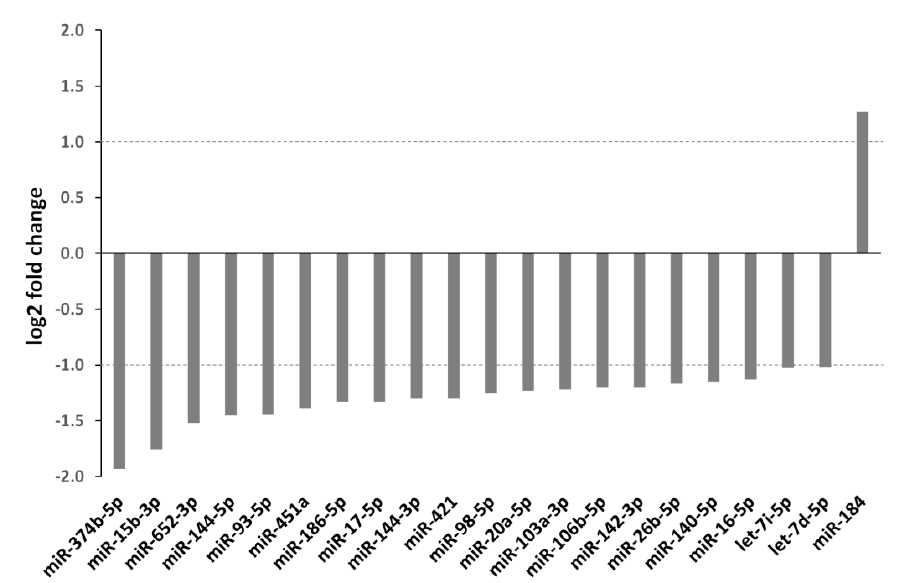
Figure 2. Radiation-induced changes in plasma miRNA levels. The deregulated miRNAs in the plasma of tumor-bearing (MIA PaCa-2) mice after 5 Gy irradiation of the tumor when compared with the plasma of tumor-bearing (MIA PaCa-2) mice receiving sham (0 Gy) irradiation are shown. Positive log2 fold changes indicate miRNAs upregulated in the plasma of irradiated mice compared to plasma of unirradiated mice whereas negative log2 fold changes indicate miRNAs downregulated in plasma of irradiated mice. Significant miRNAs were selected based on a log2 fold change ≥ | 1 | and an adjusted p -value of ≤ 0.05. Only transcripts with a base mean ≥ 50 were